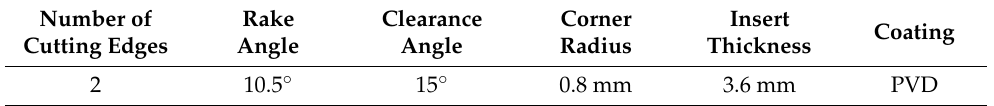
Table 4. The geometry of the milling insert.